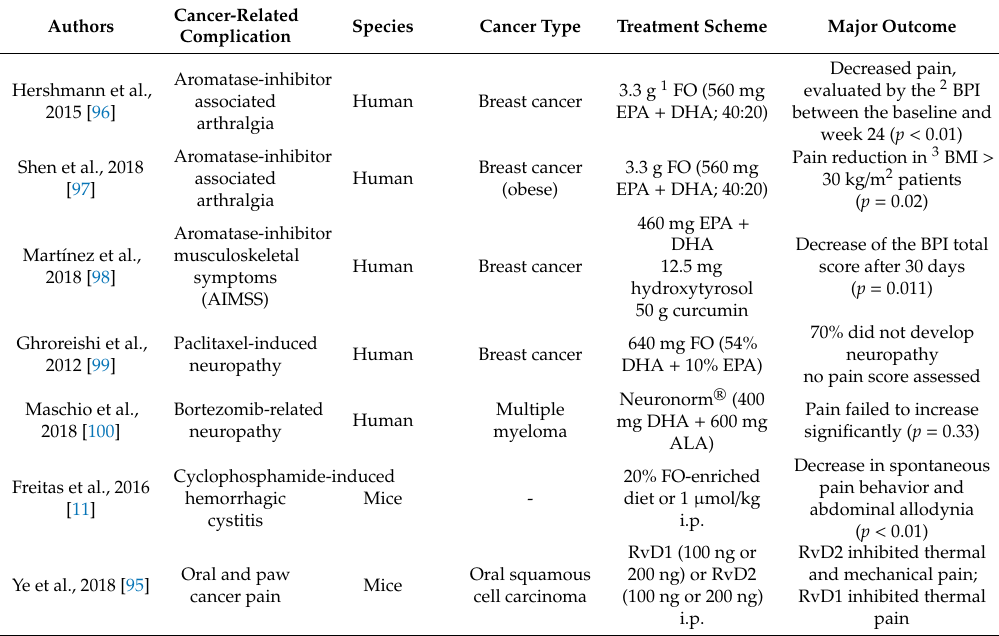
Table 1. A summary of the articles discussed above regarding the e ff ects of omega-3 PUFAs in cancer and cancer-treatment